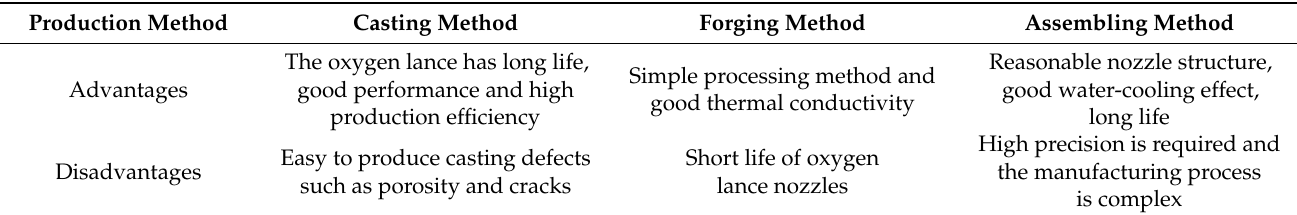
Table 1. Oxygen lance manufacturings method and characteristics.